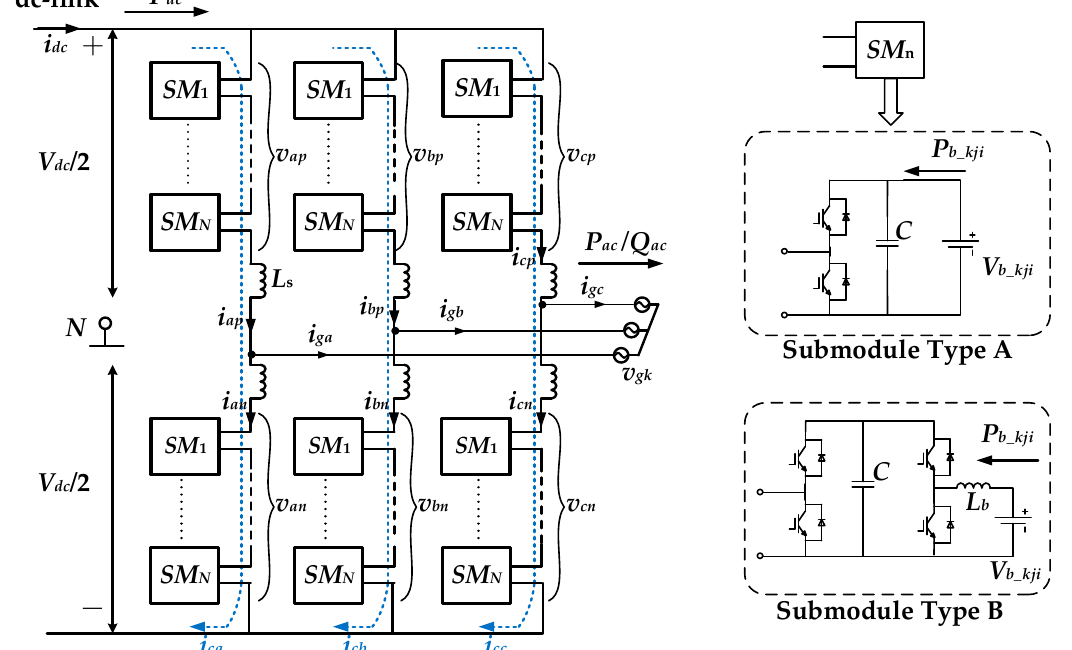
Figure 2. Topology of the three-phase MMC- battery energy storage system (BESS).